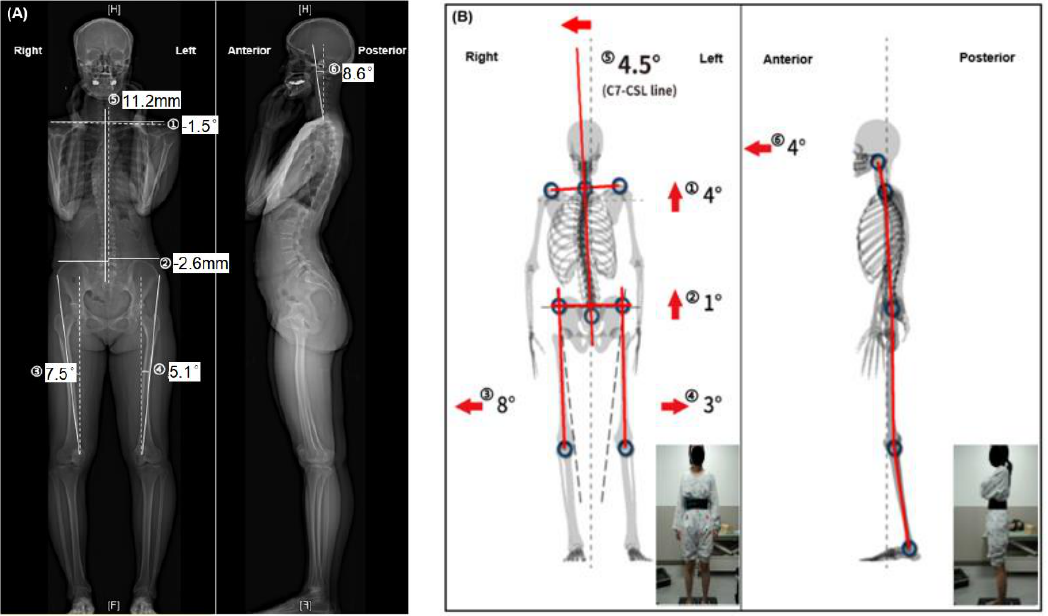
Figure 3. ( A ) The EOS and ( B ) PAViR data in the same subject: ① Asymmetric clavicle height, ② pelvic oblique, ③ right Q angles of the knee, ④ left Q angles of the knee, ⑤ the center of 7th cervical vertebra-central sacral line (C7-CSL), ⑥ forward head posture. All parameters are in degrees except when representing ② and ⑤ in EOS, indicated instead as distance, millimeter. Negative values mean that the left is raised or that the posture is tilted to the left. Illustration provided by MG solutions. PAViR posture analyzing and virtual reconstructing device.